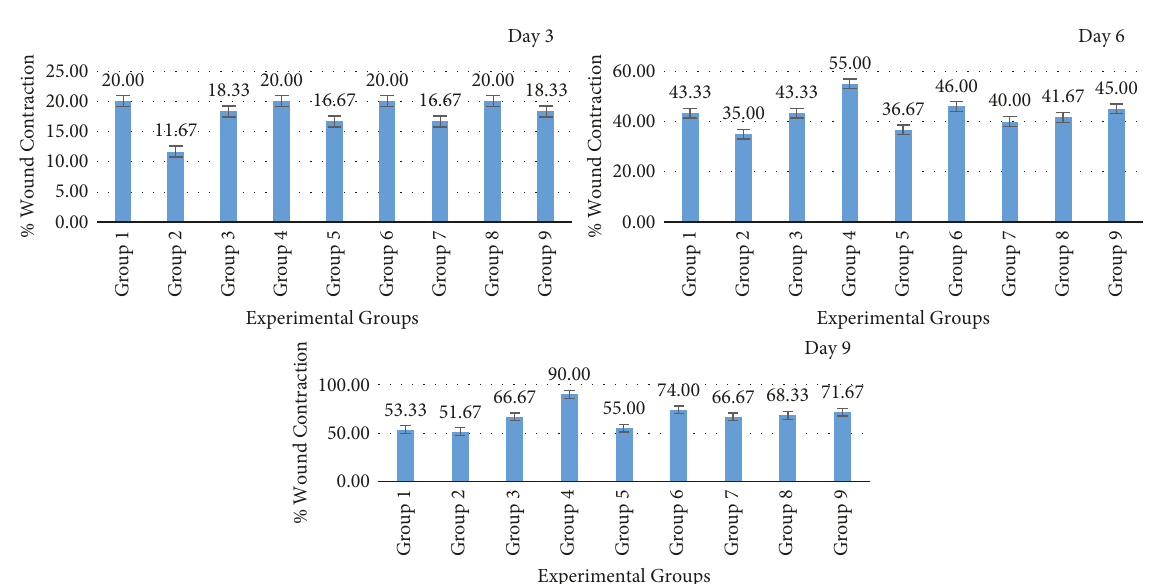
Figure 4: Wound contraction in experimental groups on days 3, 6, and 9 after wounding.